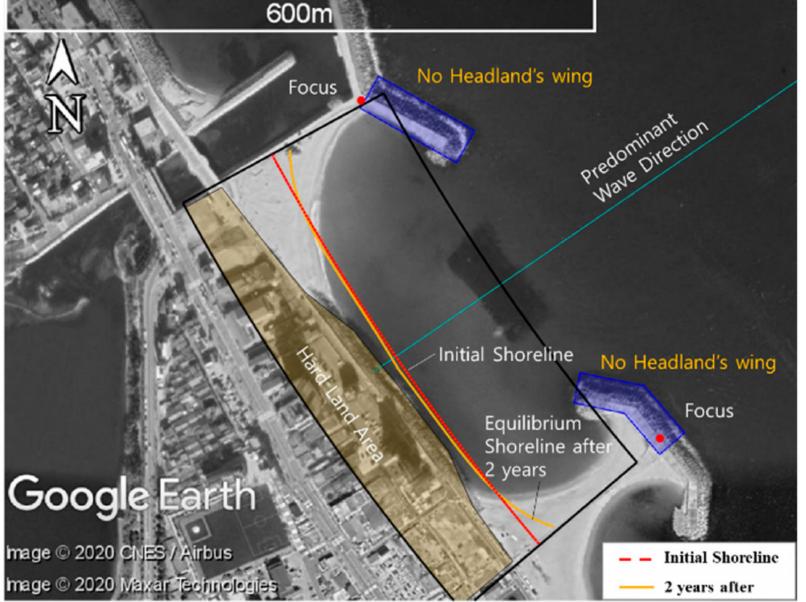
Figure 18. Results of model simulation, supposing that the double headland’s wings are removed (image from Google Earth as at April